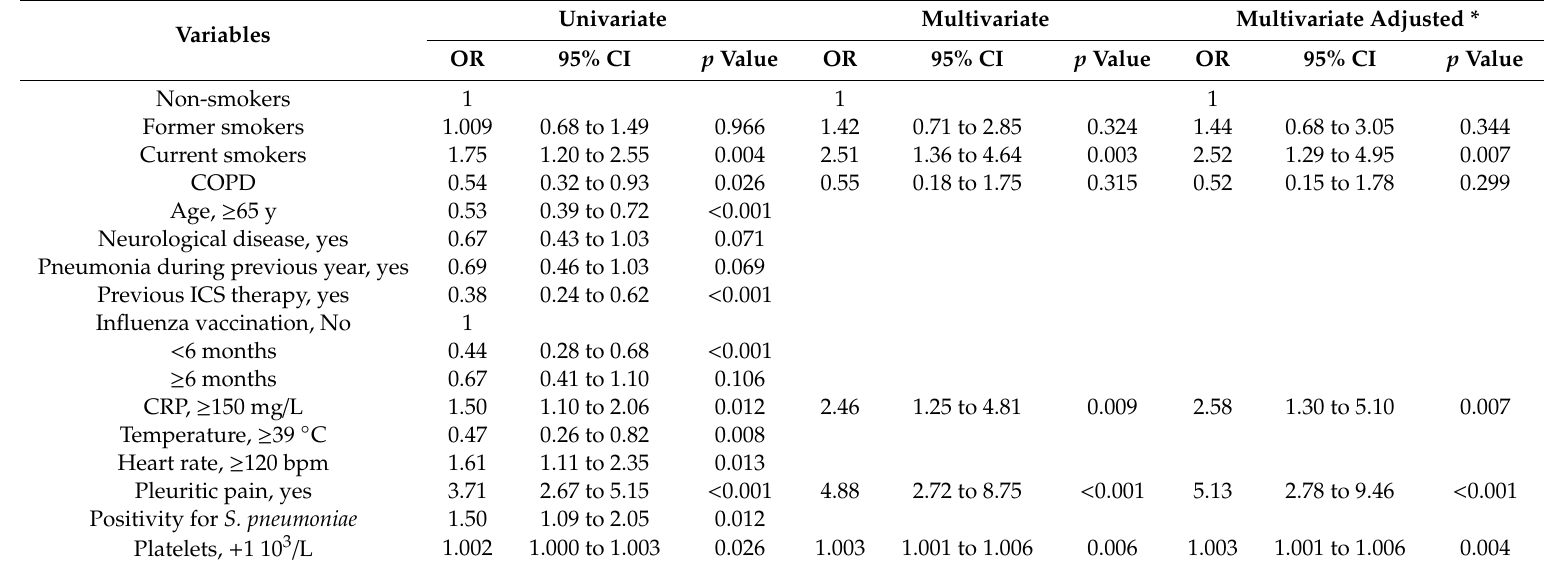
Table 6. Univariate and multivariate analysis for predicting the probability of a pleural complication. Univariate Multivariate Multivariate Adjusted * Variables OR p